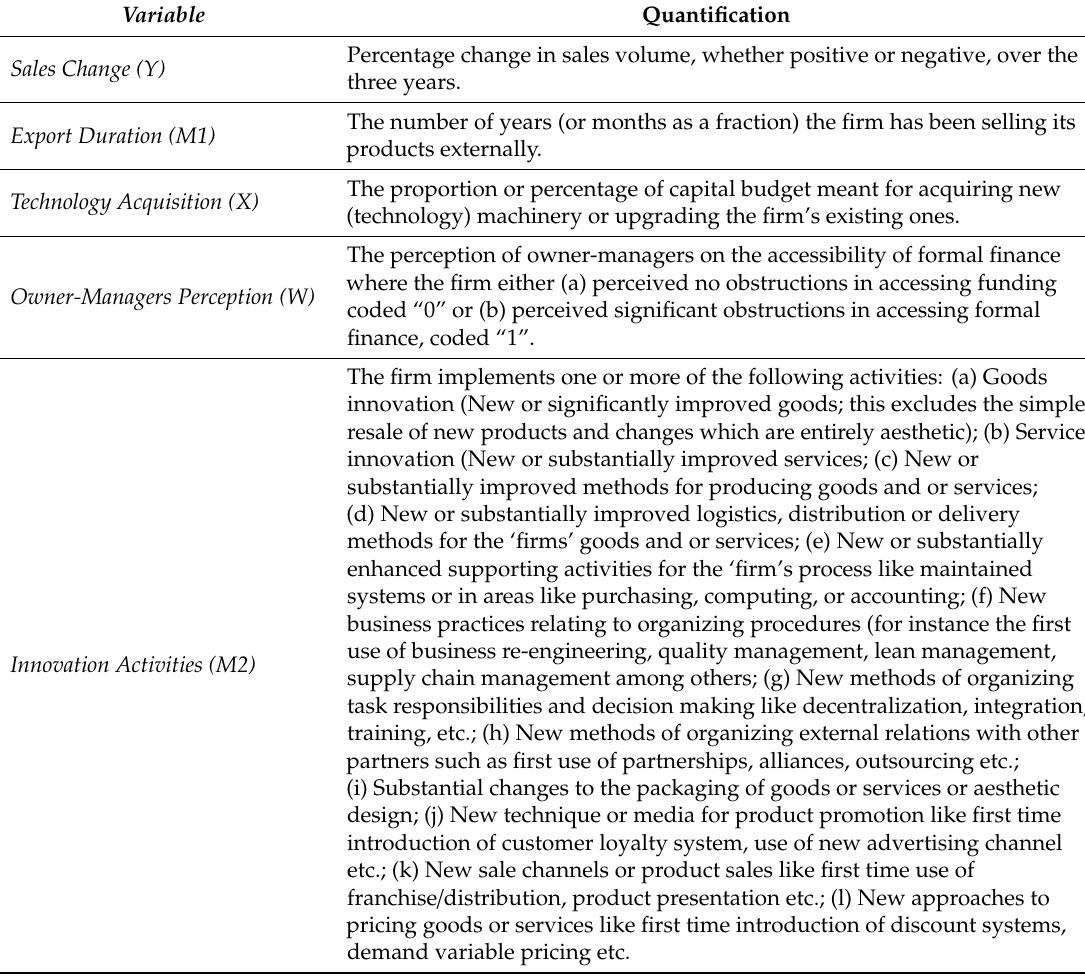
Table 1. Measurement and scaling of the